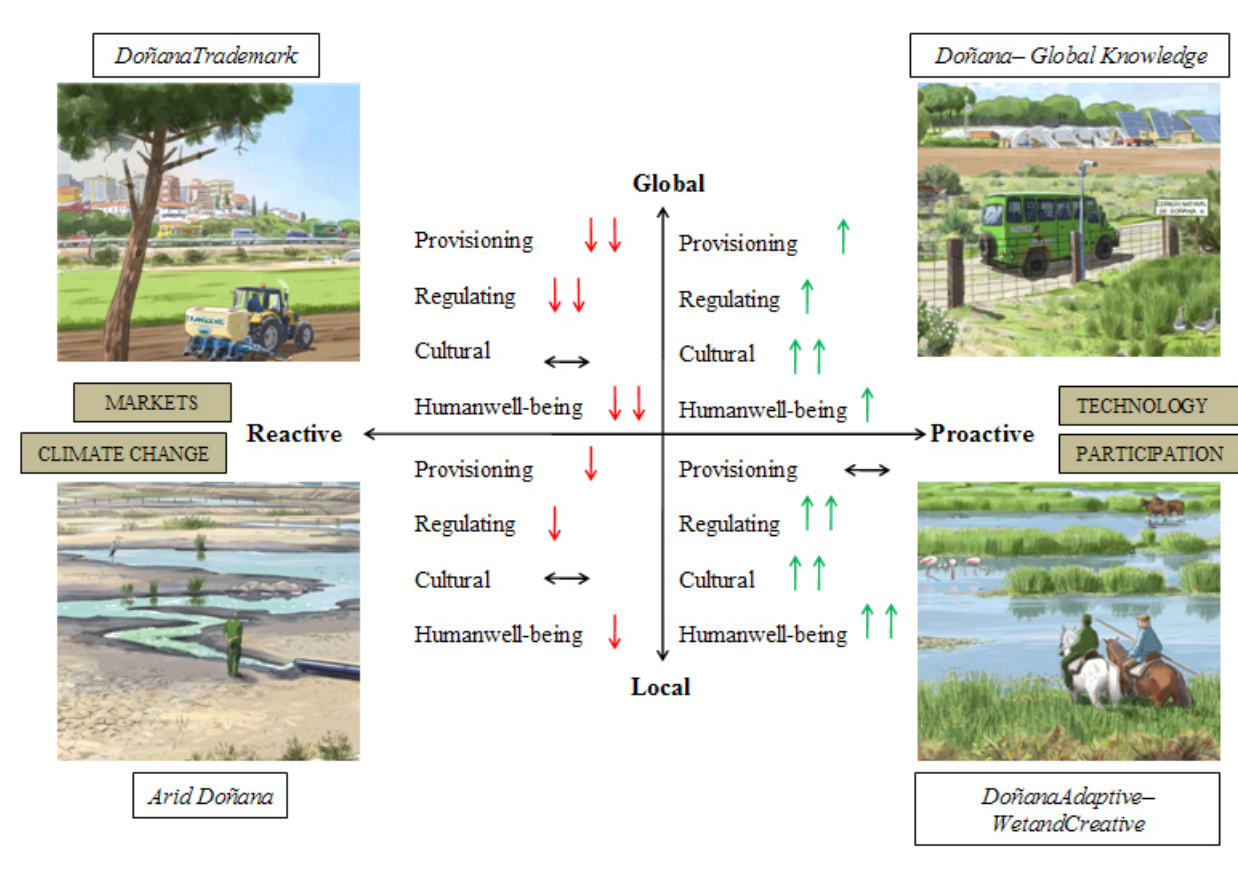
Fig. 6 . Summary of the evolution of ecosystem services and human well-being under the four scenarios. The vertical axis refers to the management and the horizontal axis refers to the main drivers of change (in